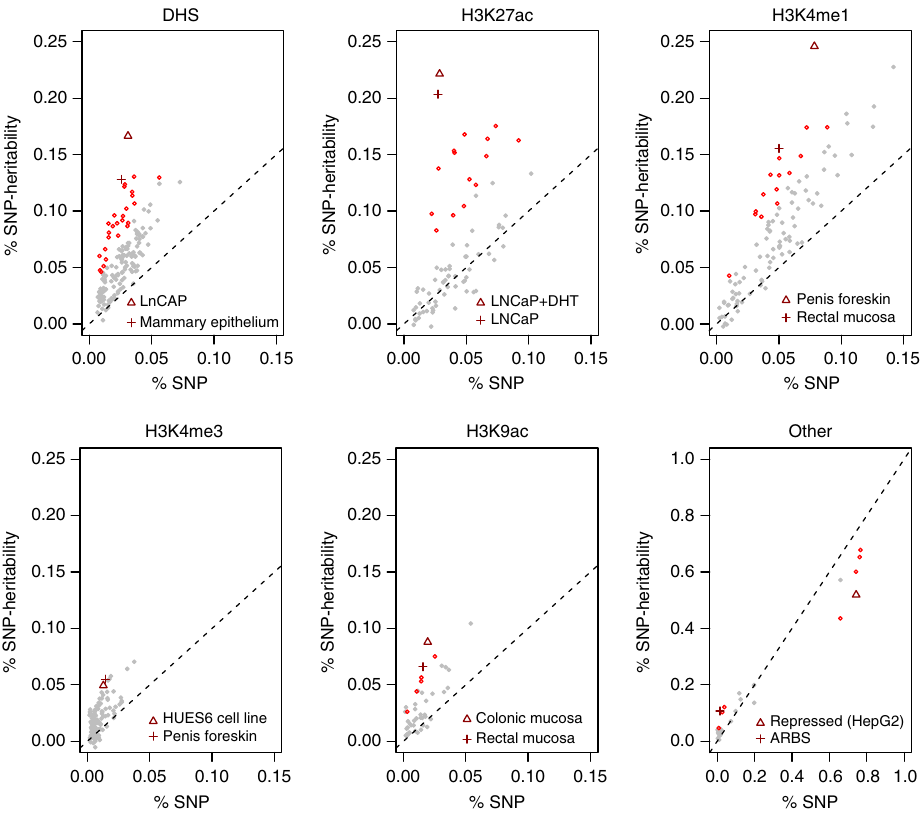
Figure 2 | Functional partitioning of heritability across six main epigenetic classes. Each point corresponds to an estimate of % SNP heritability ( y axis) from SNPs within a cell-type-specific functional annotation versus annotation size (%SNPs, x axis). Overall, 544 annotations were tested, and red points indicate significant deviations from the null of %h 2 equal to %SNPs after accounting for all tests. The two most significant annotations in each class are g shown with triangle/cross, respectively, and labelled in bottom right (see Supplementary Data for all